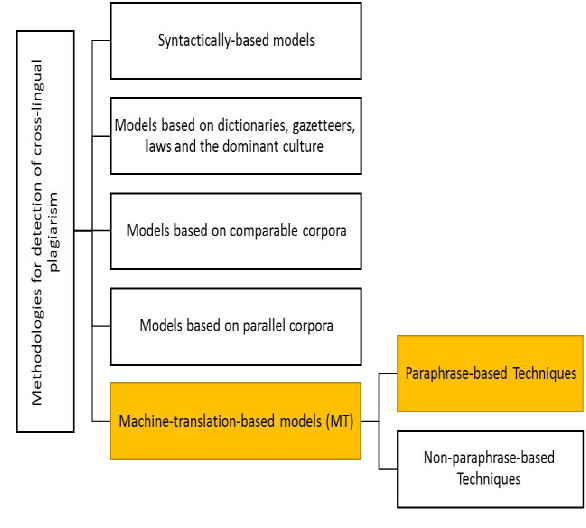
Figure 4. Taxonomy of different methodologies for detection of cross-lingual